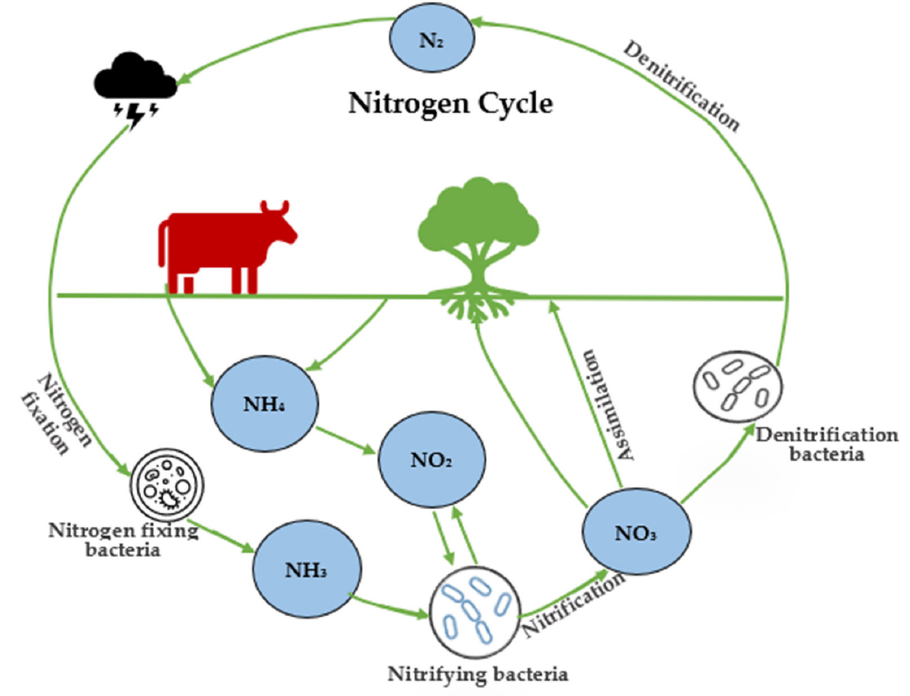
Figure 2. Nitrogen cycle in the environment including Nitrogen Assimilation.